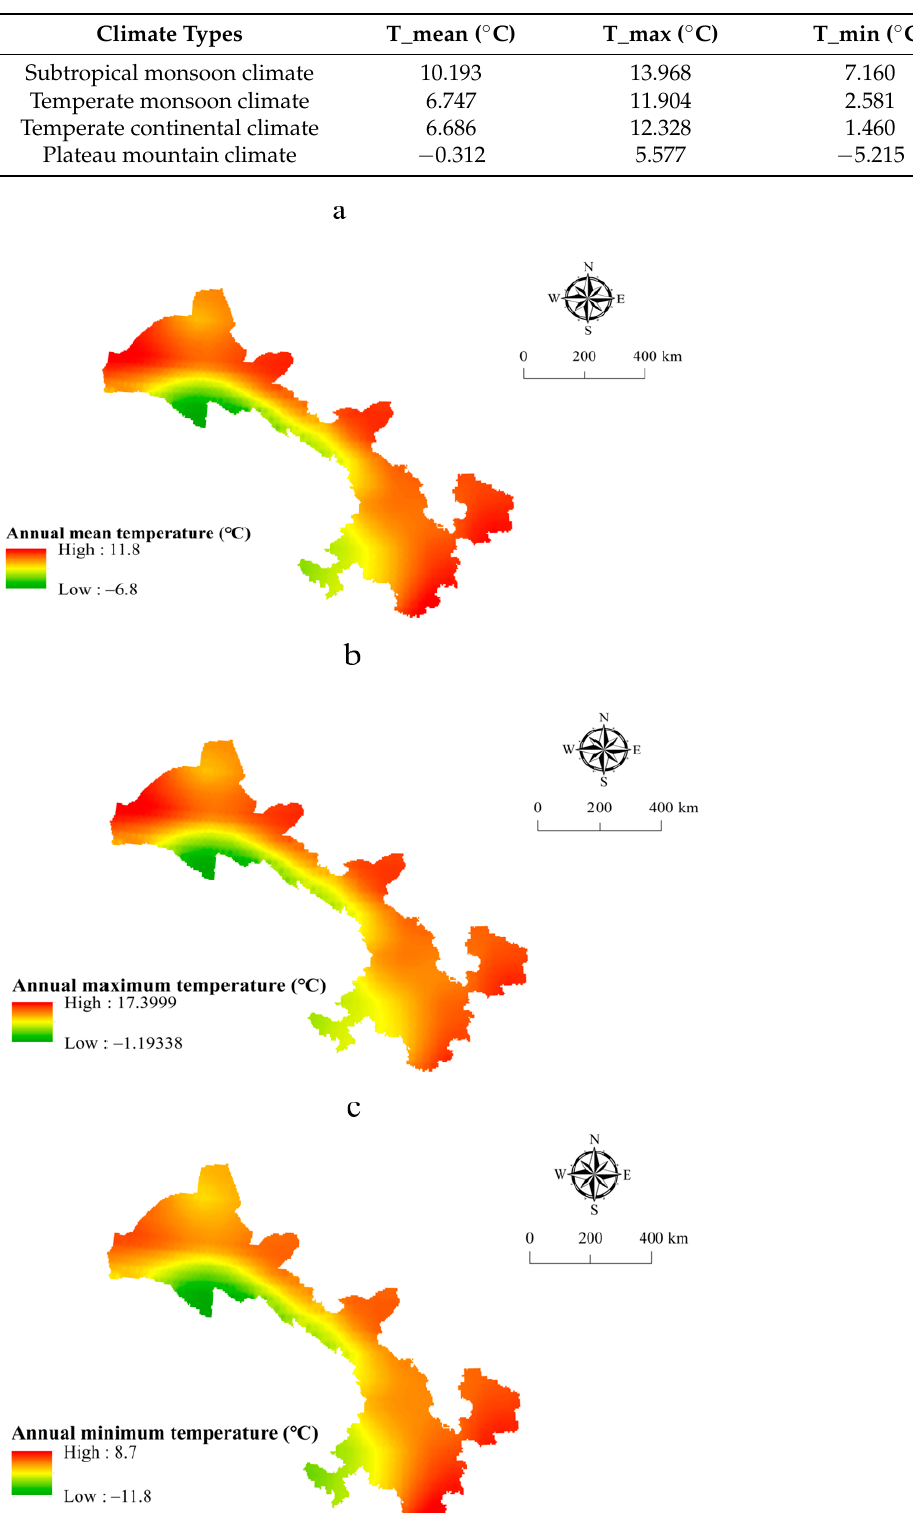
Table 1. Annual ERA-Interim temperature data for different climate zones.